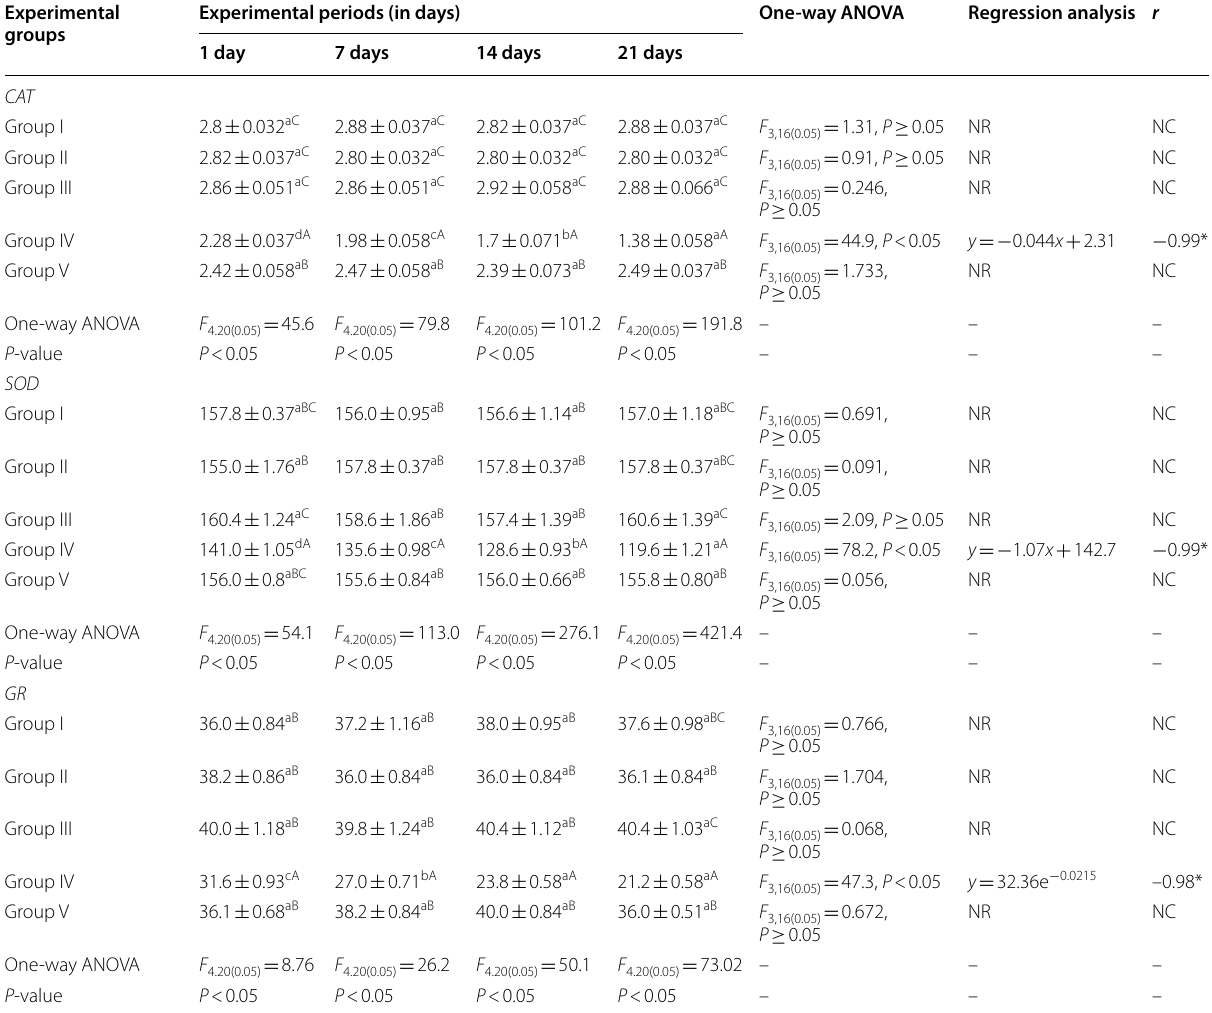
Table 6 The activity of catalase (CAT, U/ml), superoxide dismutase (SOD, U/ml), and glutathione reductase (GR, U/ml) in serum of rats in groups I to V, after 1, 7, 14 and 21 days of